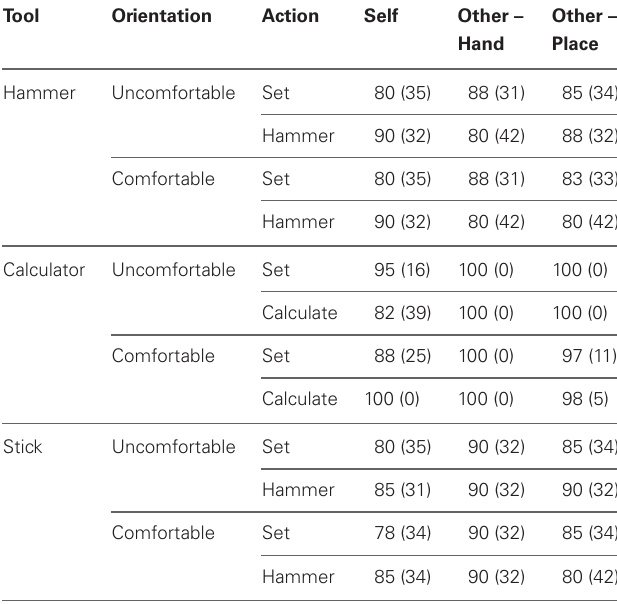
Table 2 | Percentage (%) of trials participants used dominant hand. Table 3 | Percentage (%) of trials participants placed the tool on the contralateral